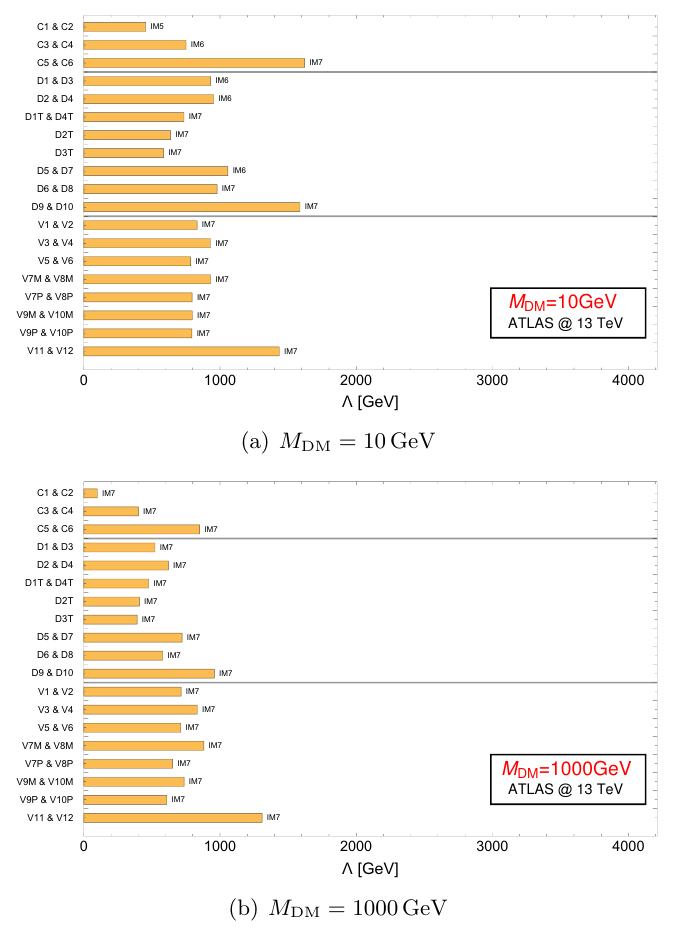
Figure 14 . Observed limits on the UV cut-o(cid:11) (cid:3) from the ATLAS search of ref. [3] using 13 TeV data with a luminosity of 3.2 fb (cid:0) 1 . See the caption of (cid:12)gure 9 for more details about the interpretation of the